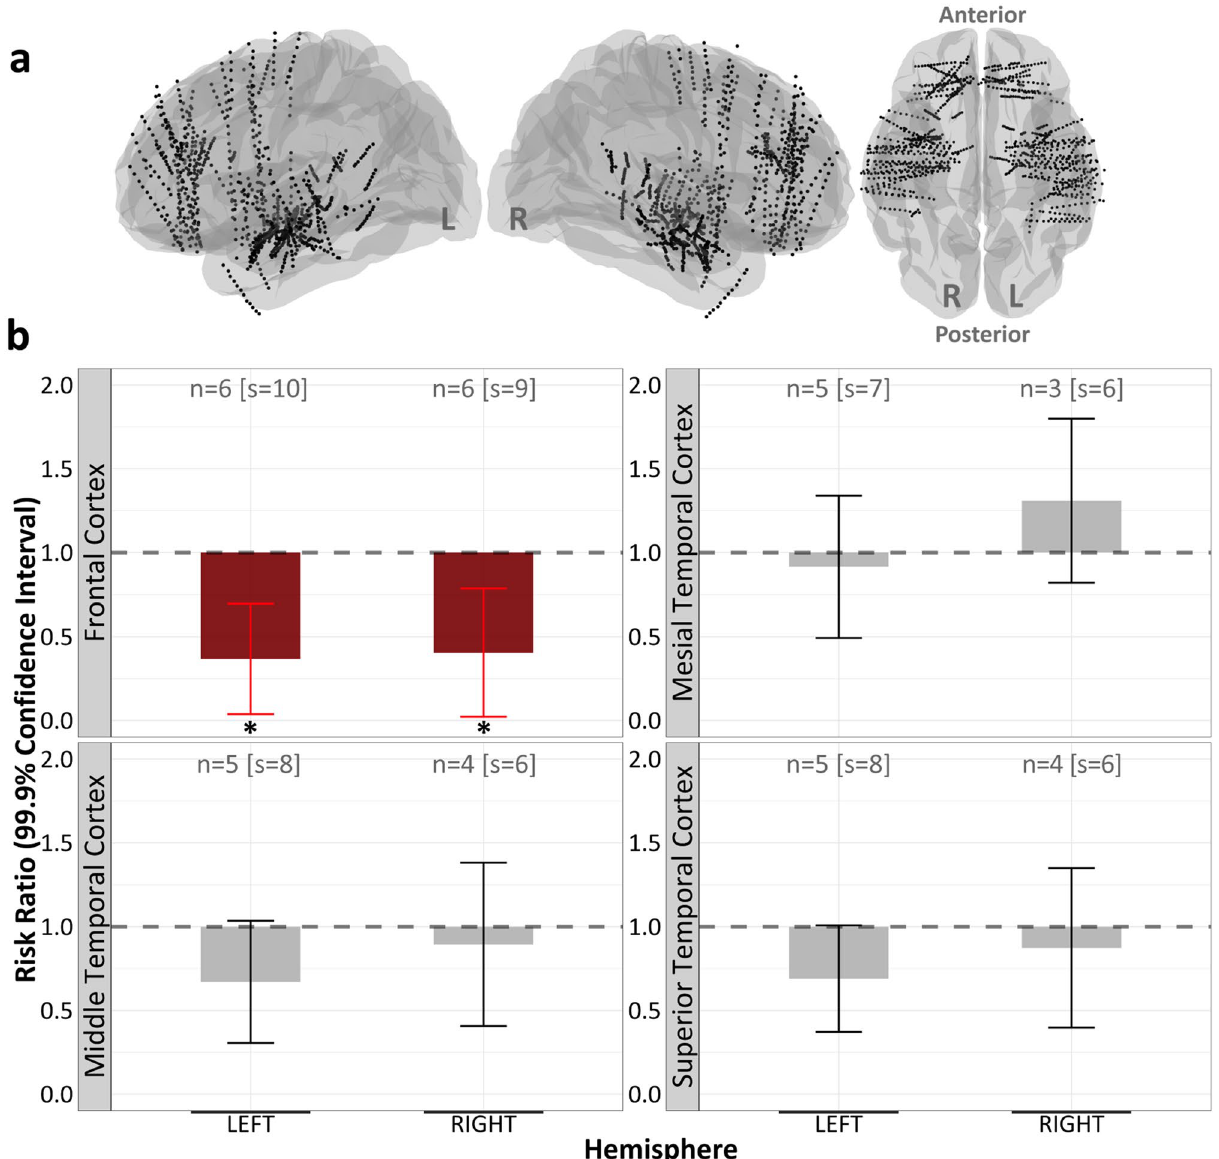
Figure 4. Bilateral frontal regions responded to K448. ( a ) Stereo-EEG electrodes aggregated across subjects. ( b ) Linear mixed models revealed nonsignificant reductions in all regions other than the bilateral frontal cortices (right frontal cortex (FC) % reduction = 59.55, p = 0.049; left FC % reduction = 63.25, p = 0.017). “n” represents the number of subjects with electrode coverage in the corresponding brain region and “s” represents the number of unique experiment sessions. Significance at * p < 0.05, ** p < 0.01, *** p <